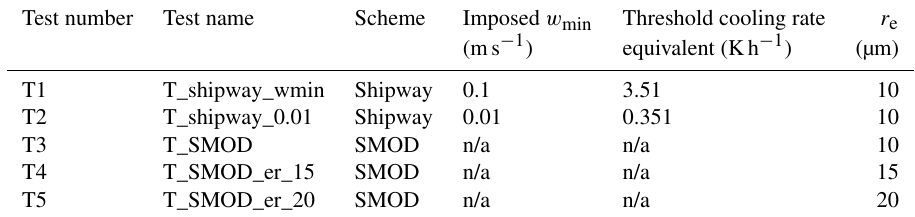
Table 5. Details of the simulations using the Shipway and SMOD activation scheme. The value of w min has been lowered from 0.1 to 0.01ms − 1 based on the results from Sect. 4. The cooling rate equivalent is calculated using the dry adiabatic lapse rate assumption. For SMOD, imposing a w min was not applicable (n/a).